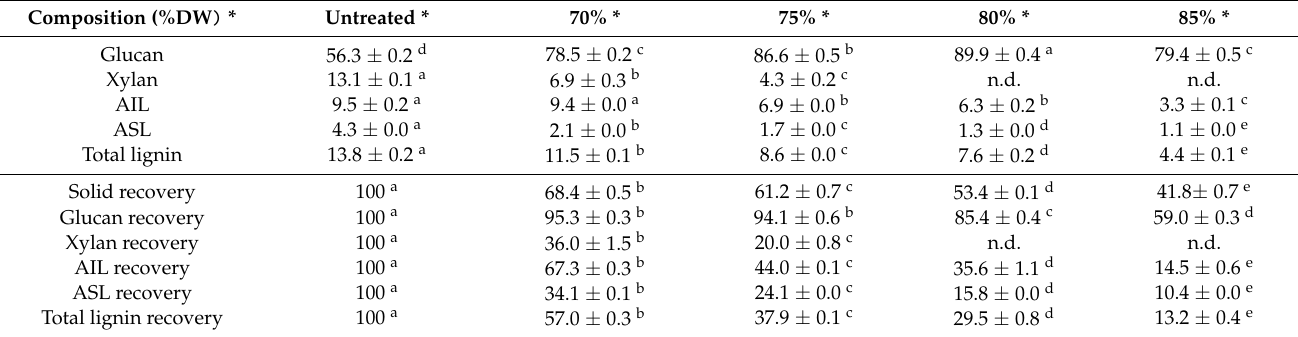
Table 2. Chemical composition of bark fiber in kenaf biomass after pretreatment.